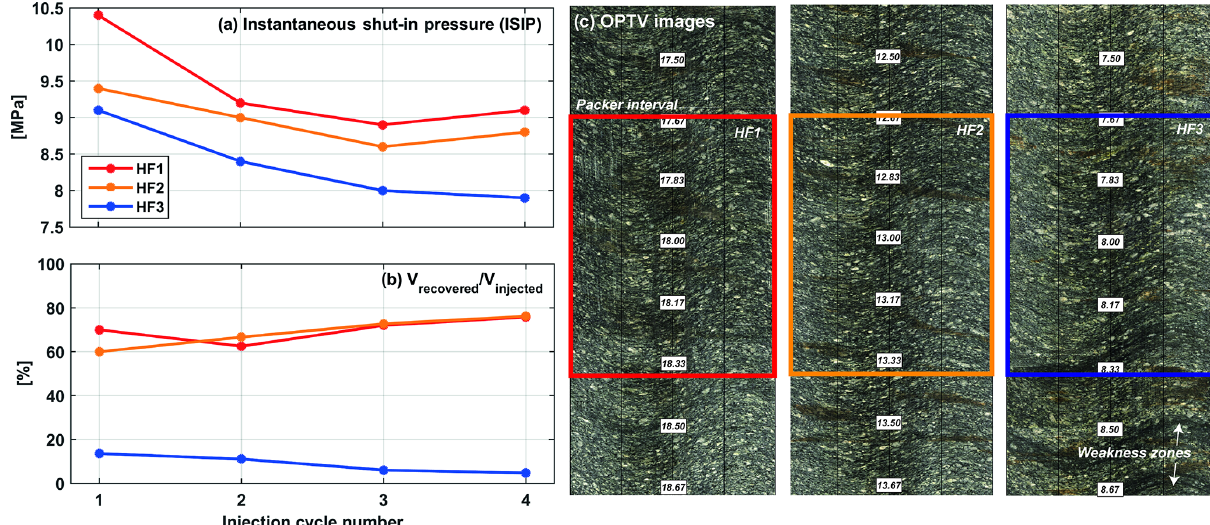
Figure 12. Hydrofracturing results: (a) development of instantaneous shut-in pressure (ISIP) and (b) relative volume recovery of injected water with cycle for the three hydrofractures. For HF3, ISIP continues to decrease with each cycle and the recovered volume is very low. (c) Optical televiewer images of the three hydrofracturing intervals.